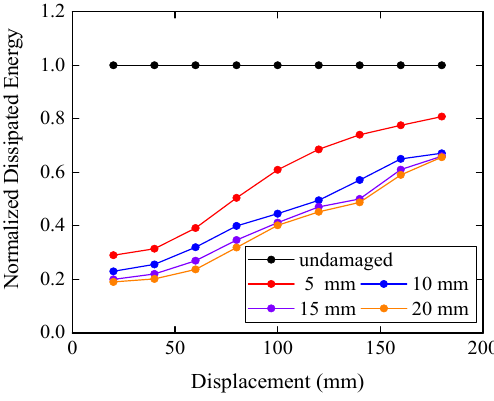
Figure 24. Normalized dissipated energy.